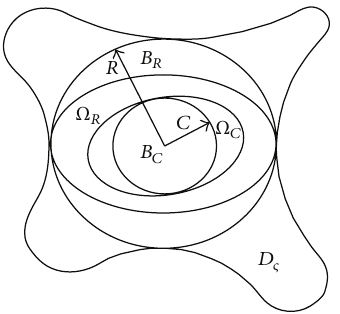
Figure 6: The geometric relation during